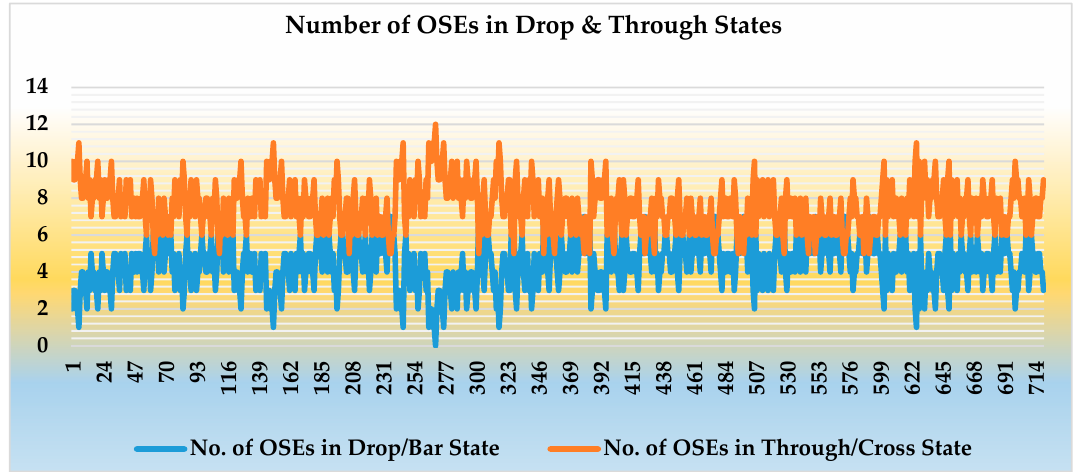
Figure 10. Number of OSEs in drop/bar and through/cross states in optimal switching combinations for optimized HCROS .